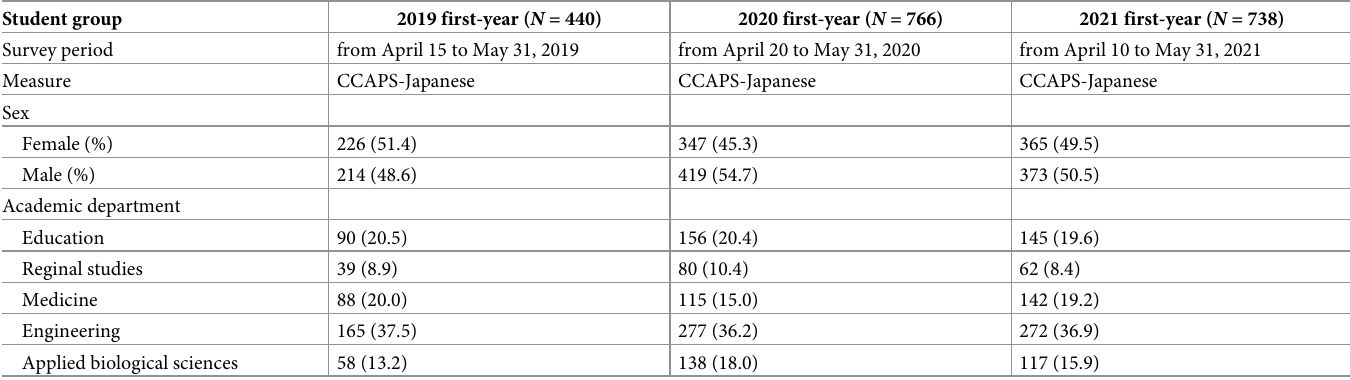
Table 1. Background characteristics of the participants in each